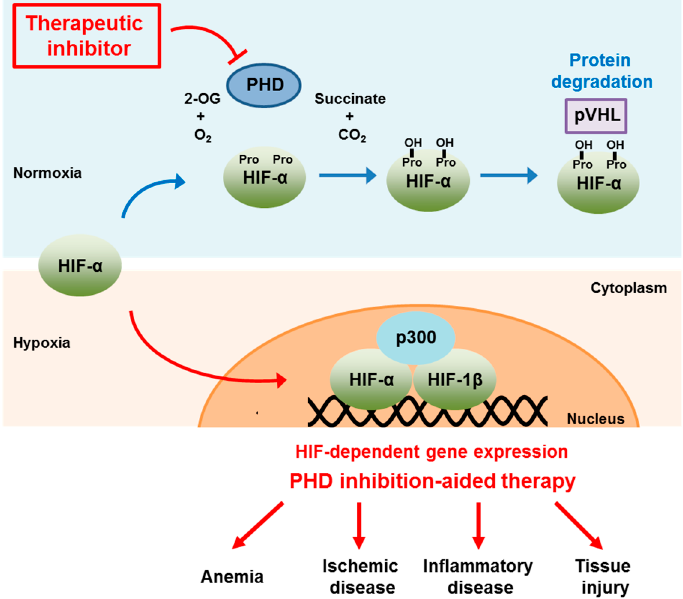
Figure 1. Schematic diagram illustrating HIF-dependent gene expression by inhibiting PHD activity and its therapeutic implications.